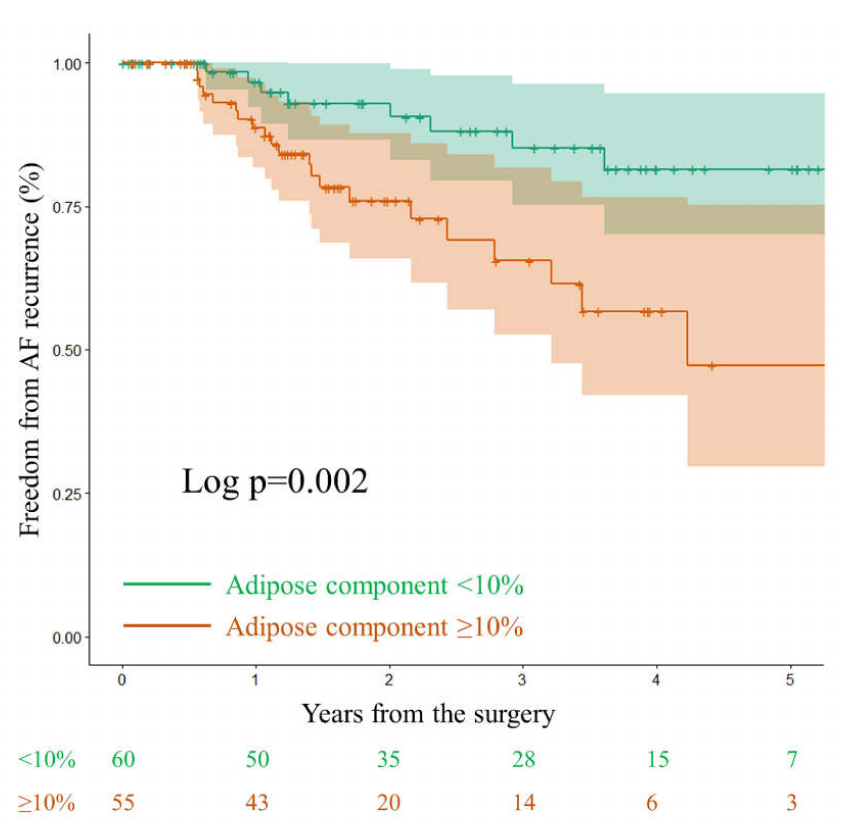
Figure 4. Freedom from atrial fibrillation recurrence rate curves for the left atrial high-adipose component group ( ≥ 10%, orange line) and low-adipose component group (<10%, green line) using the Kaplan-Meier method with 95% confidence